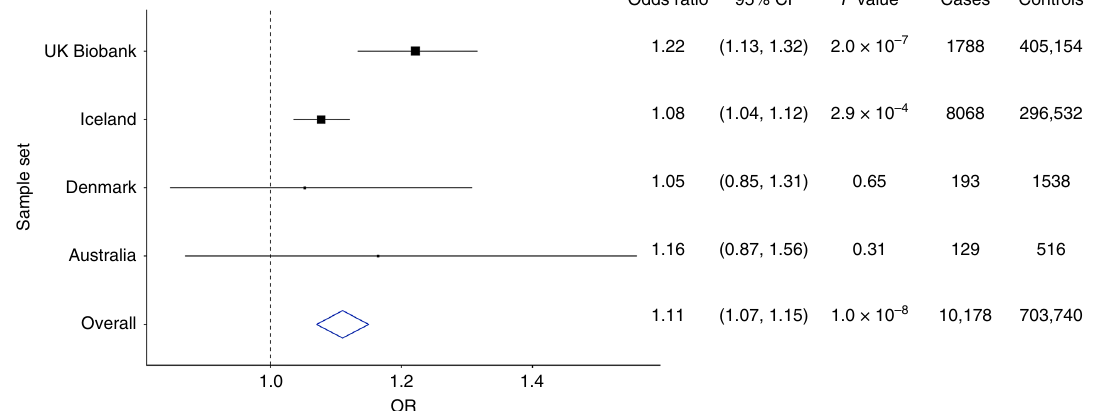
Fig. 3 Forest plot showing estimated effect of rs11614913[T] in MIR196A2 on hip fractures. The odds ratio, 95% con fi dence interval (CI), P value of association and number of cases and controls is shown for each study. Source data are provided as a Source Data fi le